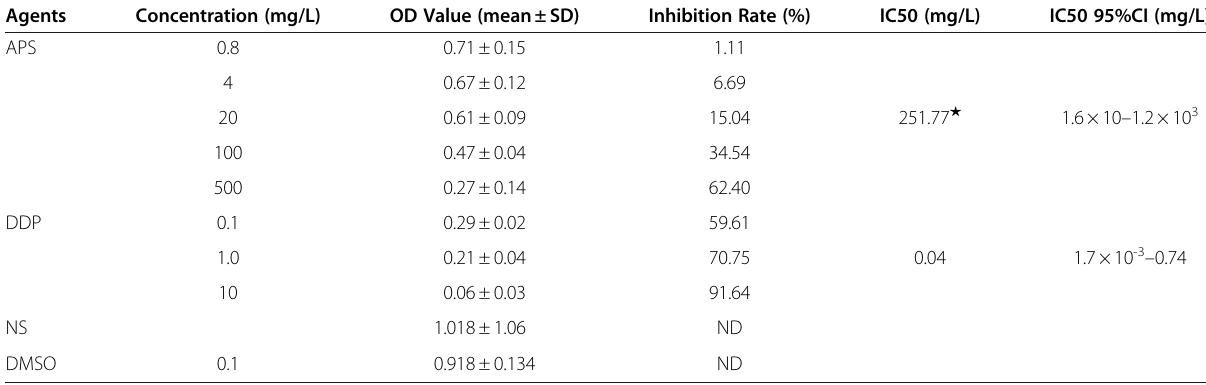
Table 1 Impact of APS on H22/ADM cell proliferation (n =6)